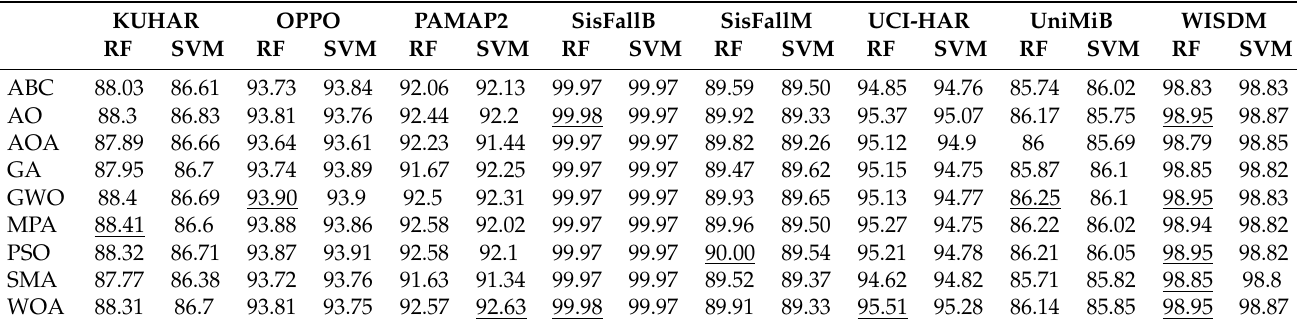
Table 2. Average classification accuracy (%) of applied MH optimizers.